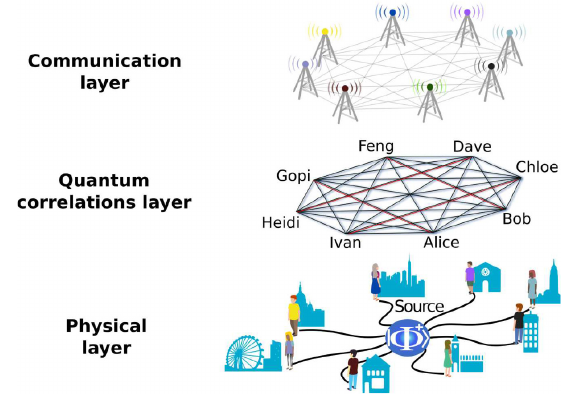
FIG. 11. The network layers. The physical layer represents the physical hardware, including the photon pair source and the opti- cal components necessary to multiplex and distribute the photons toward the users, together with their detection-analysis modules. The quantum correlation layer represents the sharing of entan- glement between users and the communication layer is where the measurement results are processed to implement QKD, flooding, and/or the SIAT